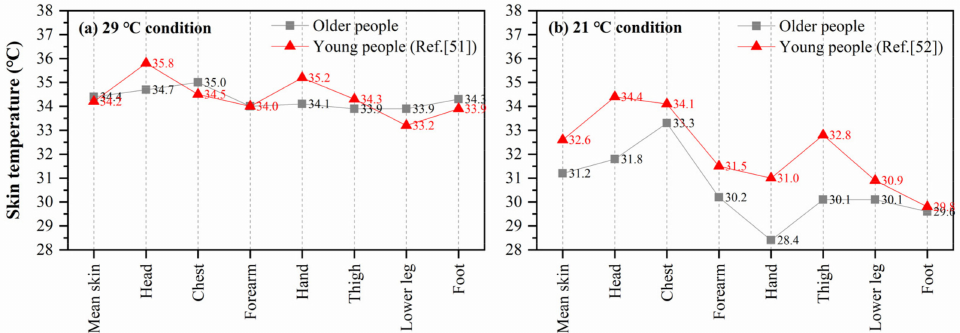
Figure 7. Comparison of mean and local skin temperature between young and older people, ( a ) 29 ◦ C condition, ( b ) 21 ◦ C condition.